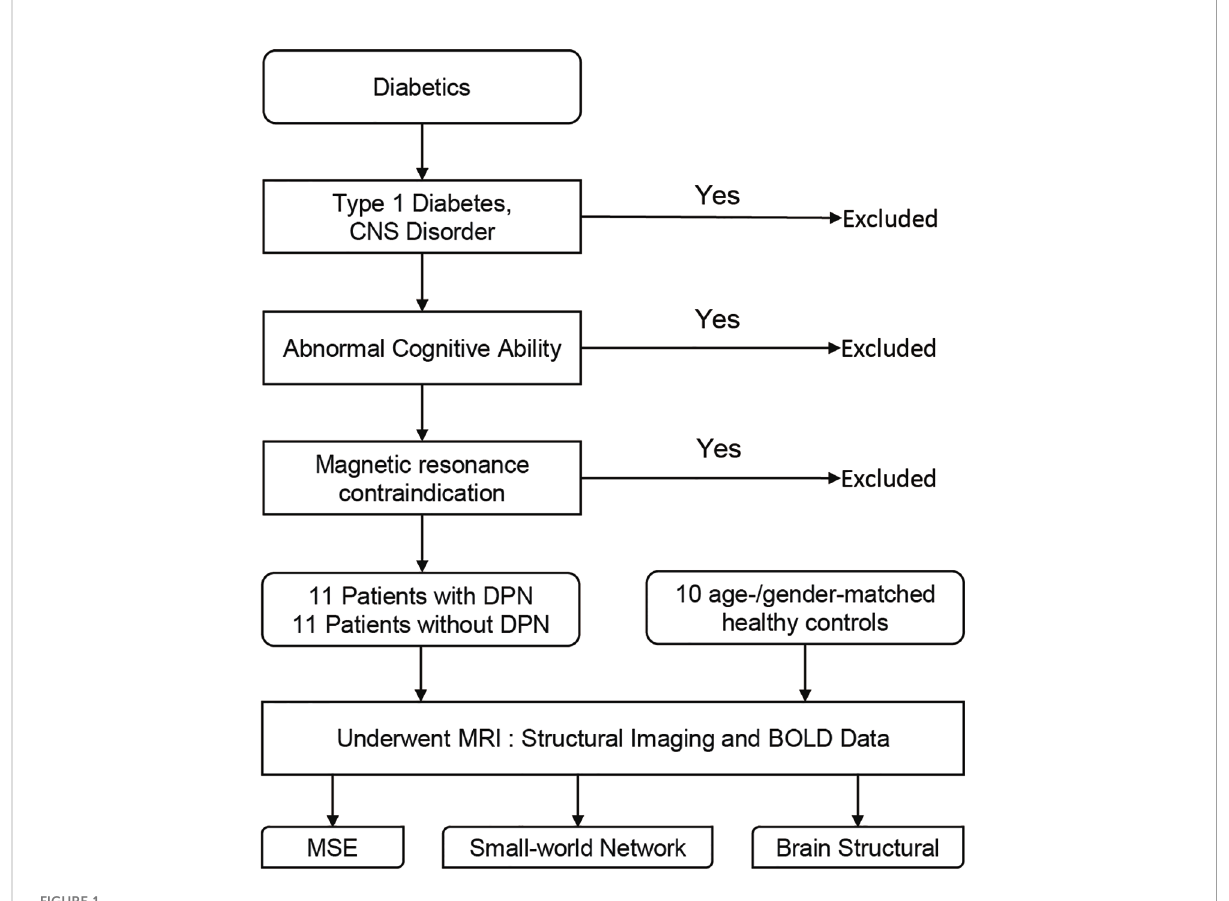
FIGURE 1 A fl ow chart of the study